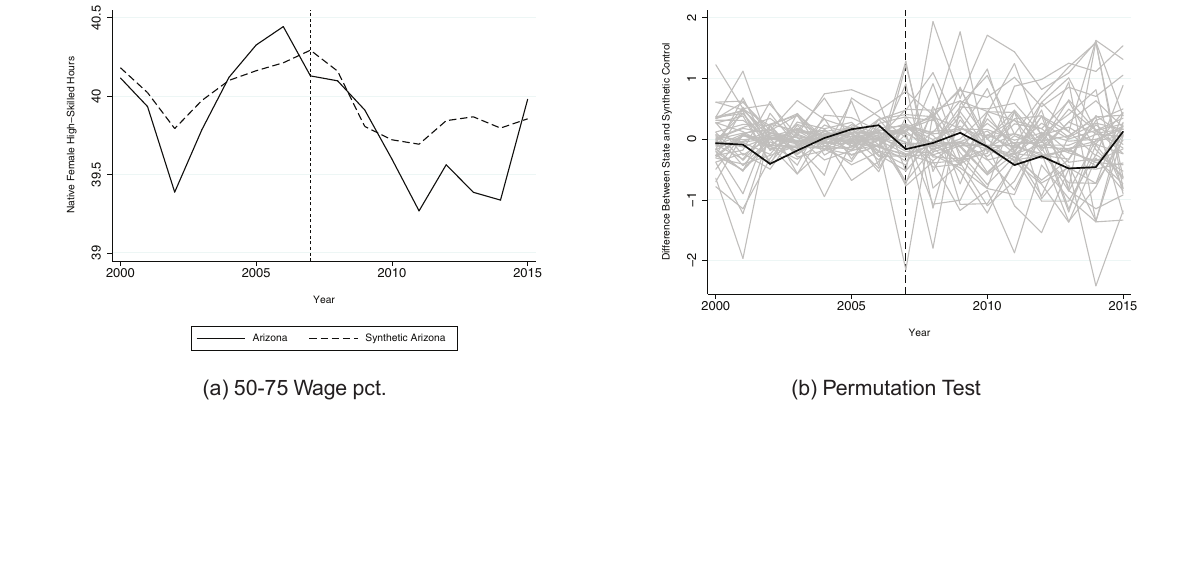
Native female weekly hours (50-75 wage pct. |